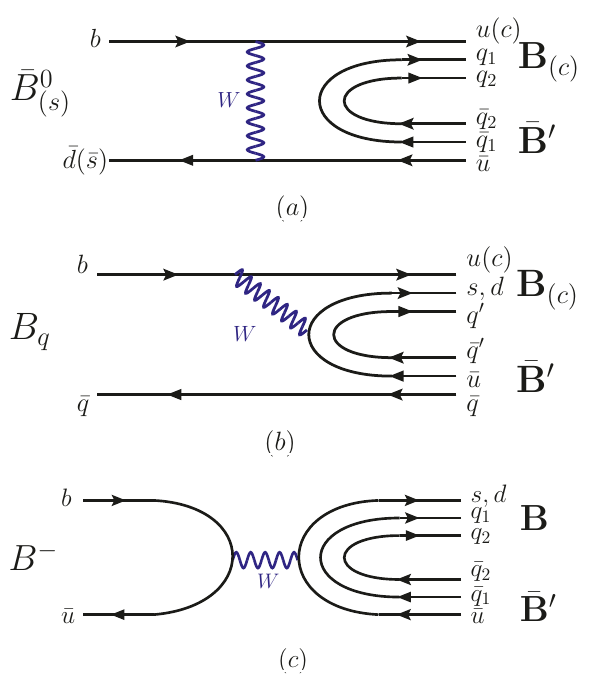
(cid:22) B 0 decays, where (a,c) depict the W -exchange and B ( c ) !